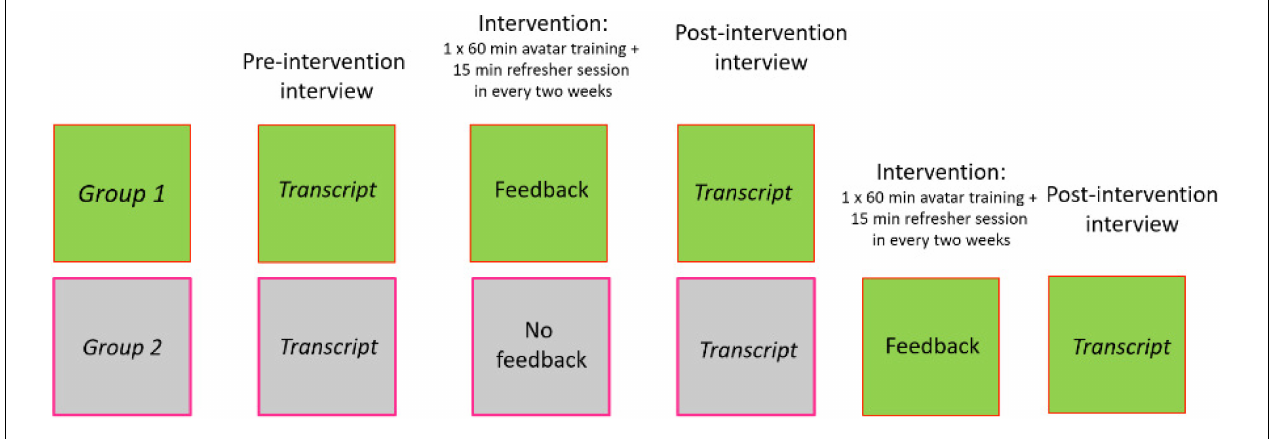
FIGURE 1 | Experimental design.